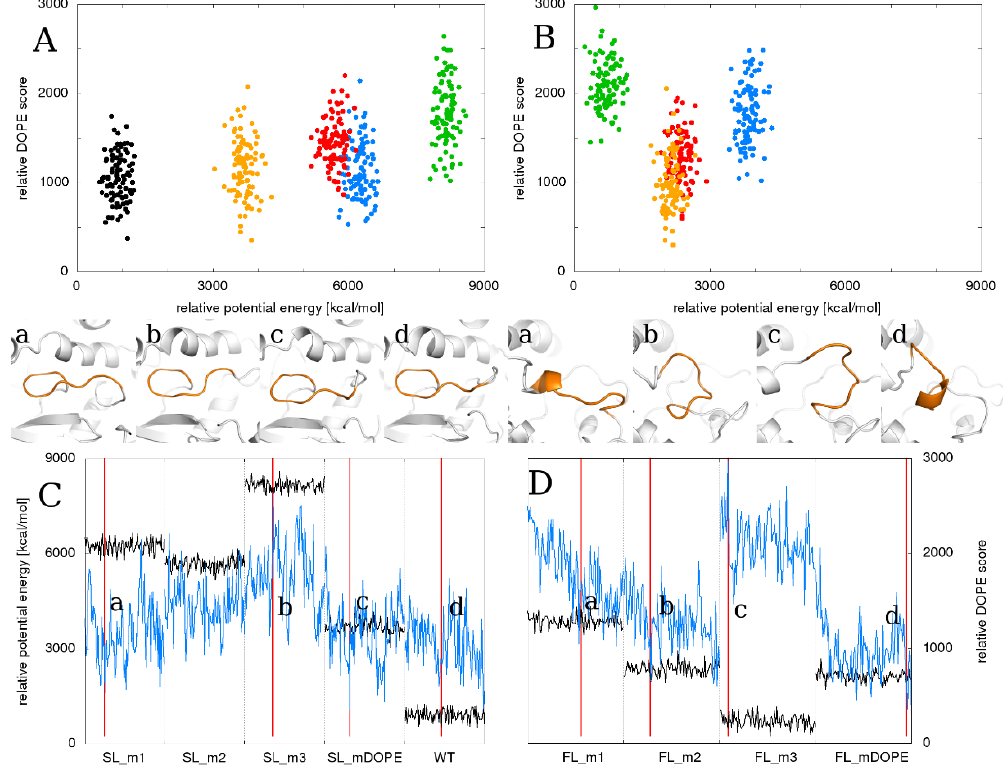
Figure 7. The relationship between the potential energy of the system, its DOPE (Discrete Optimized Protein Energy) score and the shape of its reconstructed SL using particular SL models (left side) and FL models (right side) as starting points for simulations. The potential energy (black lines) and DOPE score (blue lines) values are relative to show the distances between the models. The upper panel shows clusters of each ( A ) SL and ( B ) FL model in the context of their potential energy during MD simulation and the DOPE score of the loop model. The lower panel shows the shapes of the analyzed ( C ) SL and ( D ) FL models in particular simulations. It should be noted that the almost α -helically folded shape of the FL is the most favorable by DOPE score and at the same time the least favorable in terms of the potential energy of the system.